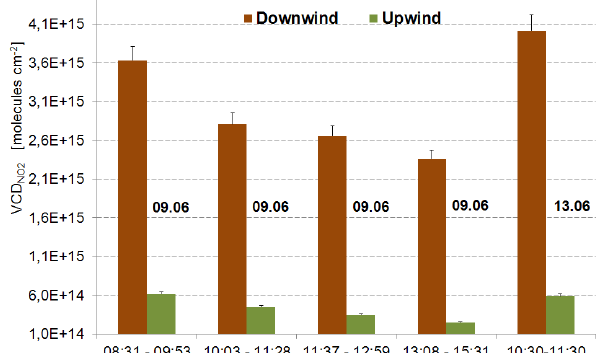
Figure 6. Results of NO 2 VCD measured simultaneously with two MAX-DOAS instruments upwind (natural forest, site (1)) and downwind (jujube field, site (3)) of Milan oasis on 9 and 13 June,